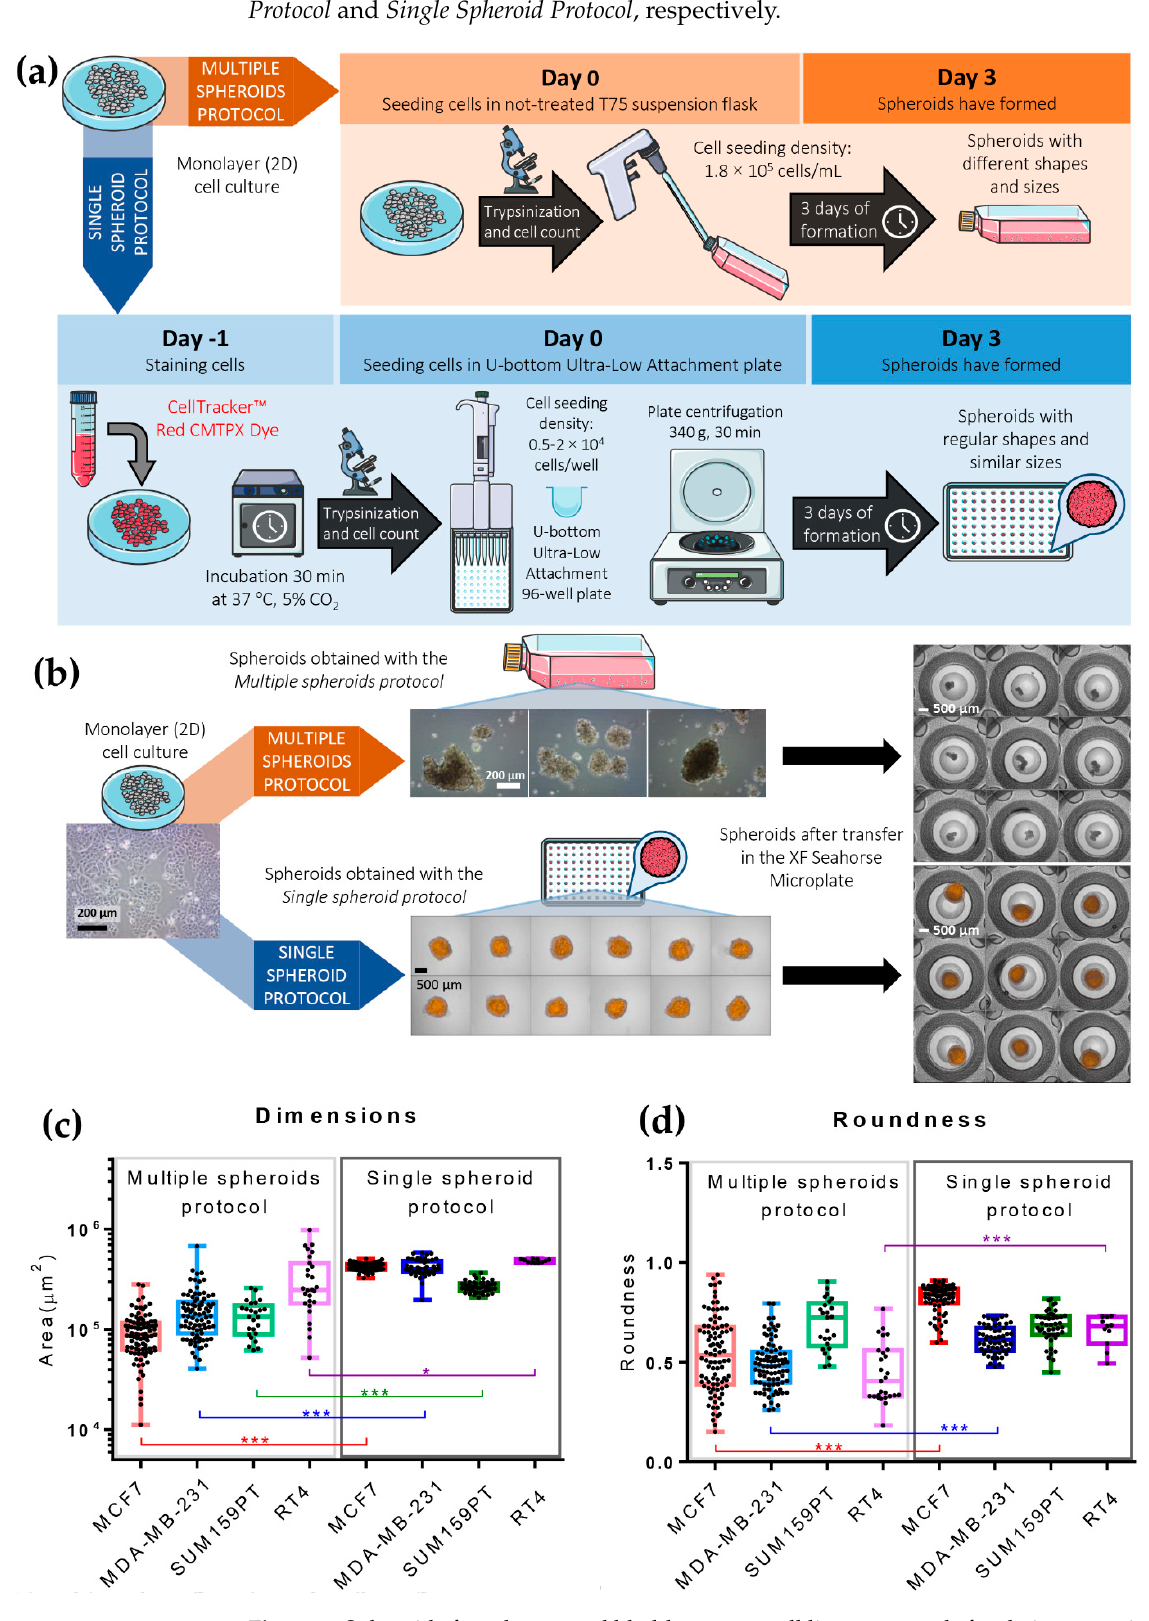
Figure 1. Spheroids from breast and bladder cancer cell lines: protocols for their generation, use in XF Seahorse bioenergetics analyses, and morphometric characterization. ( a ) Schematic